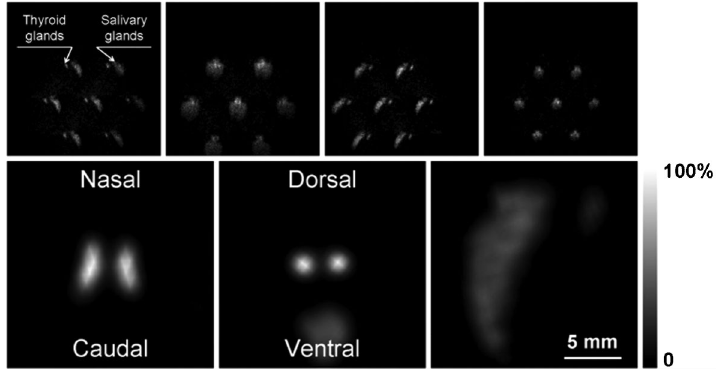
Figure 3. Thyroid images. Upper panels , sequence of 4 of the 16 projections obtained with the seven-pinhole imaging device of the mouse neck area, labeled with sodium pertechnetate. Lower panels , characteristic slices through the reconstructed volumetric model of the radioactive emission from the mouse thyroid and salivary glands along the three main axes, after 80 iterations.